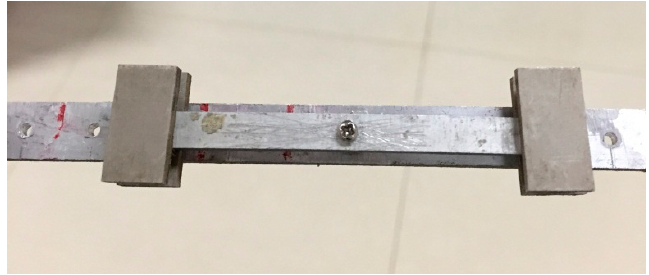
Figure 10. One period of the test specimens.